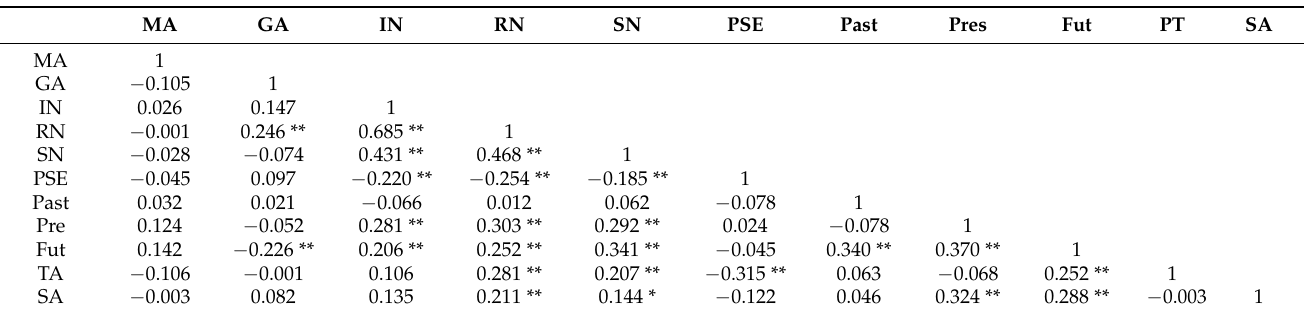
Table 1. Bivariate